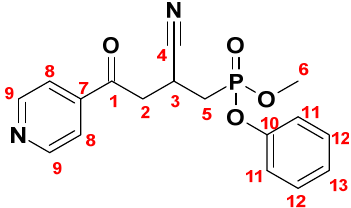
Figure 9. The structure of compound 5i .